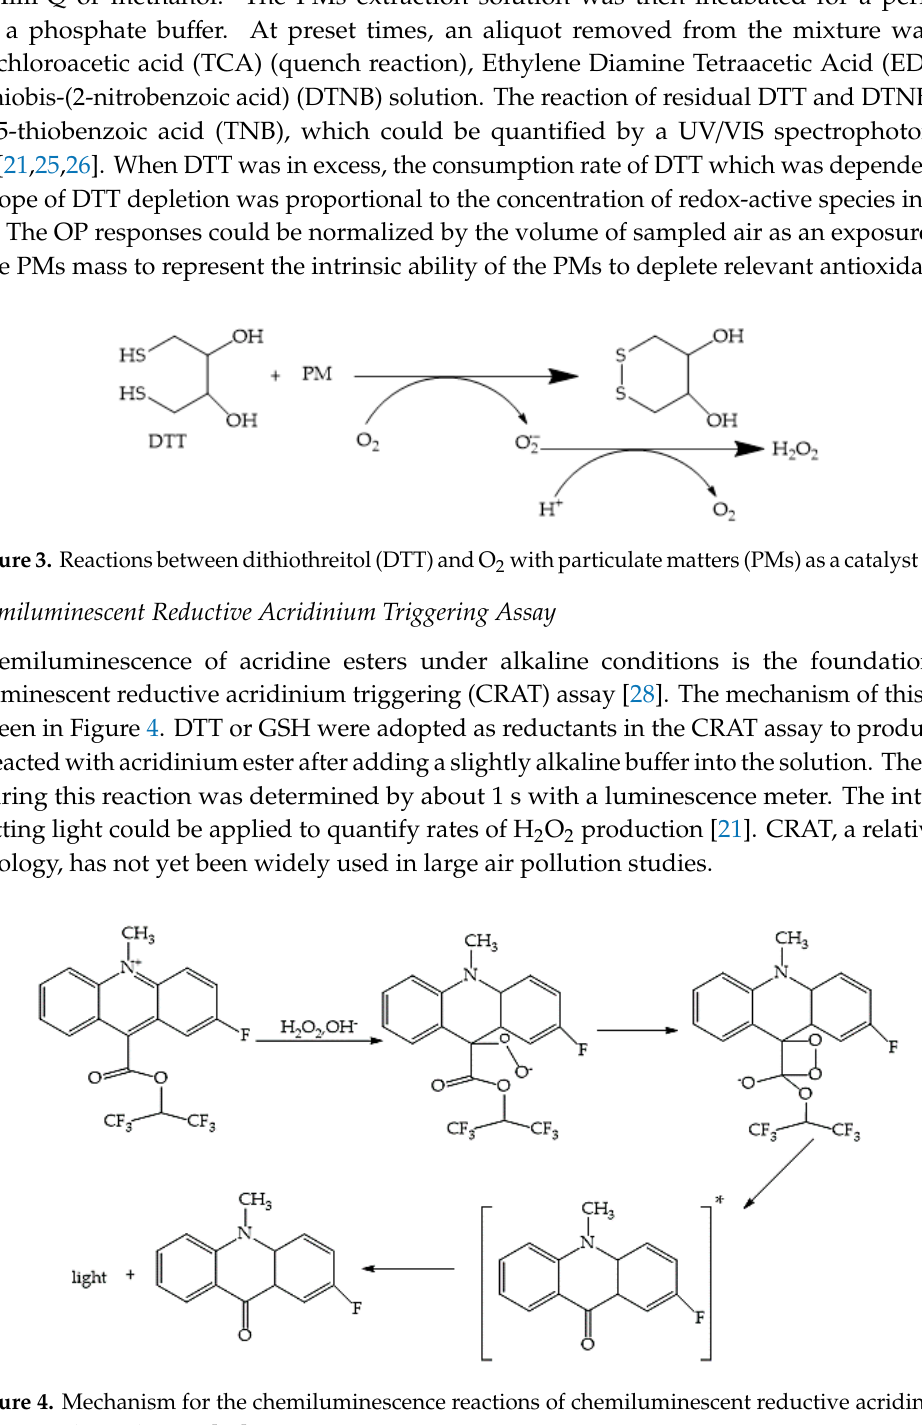
Figure 4. Mechanism for the chemiluminescence reactions of chemiluminescent reductive acridinium triggering (CRAT) assay [28].